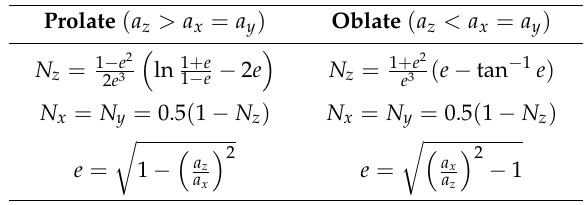
Figure 2. The spheroidal represents a vertically aligned prolate ice particle in the Cartesian coordinate system. The direction of wave propagation is given by vector k , the h and v vectors represent the horizontal and the vertically polarized wave, and θ is incidence angle. The degree of anisotropy is given by axial ratio ( a z / a x ). The spheroidal has width a x or a y ( a x = a y ), and the length a z (adapted from [8]). Table 2. Special cases of the depolarization factors N i ( i ∈ x , y , z ) for prolate and oblate particle shapes, particle shape is controlled by degree of anisotropy ( A ) given by axial ratio ( a z / a x